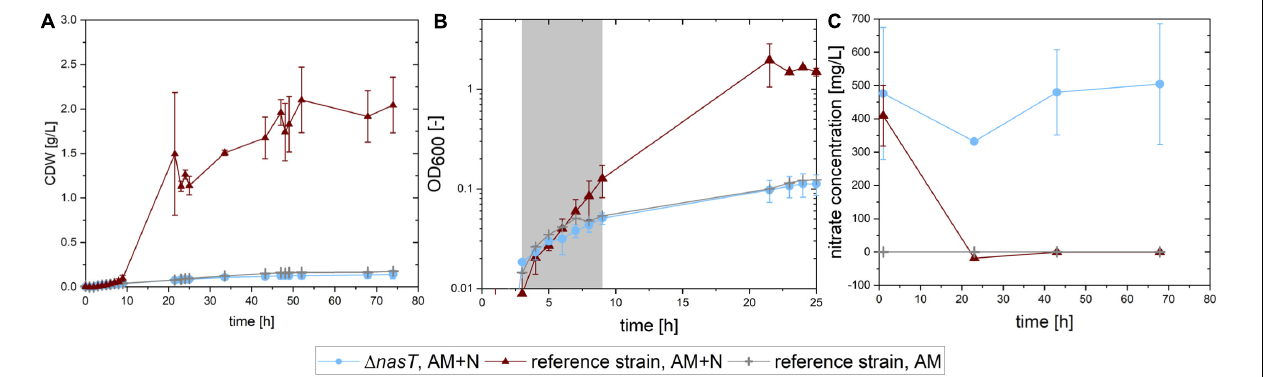
FIGURE 2 | Growth of P. putida cscRABY and P. putida cscRABY (cid:49) nasT on sucrose. P. putida cscRABY (red triangles) and P. putida cscRABY (cid:49) nasT (blue circles) were grown in M9 medium with low ammonium concentrations (AM = 0.03 g/L NH 4 Cl) and with or without the addition of nitrate (N = 1 g/L NaNO 3 ) to simulate the conditions of the co-cultivation. (A) The development of the cellular dry weight (CDW) during the cultivation. CDW was calculated using an OD/CDW correlation (see Supplementary Figure S3 ). (B) The optical density measured at 600 nm along growth. The growth rate µ (see Table 2 ) was determined in the exponential growth phase (gray shaded area). (C) The nitrate concentration in the supernatant of the cultures.